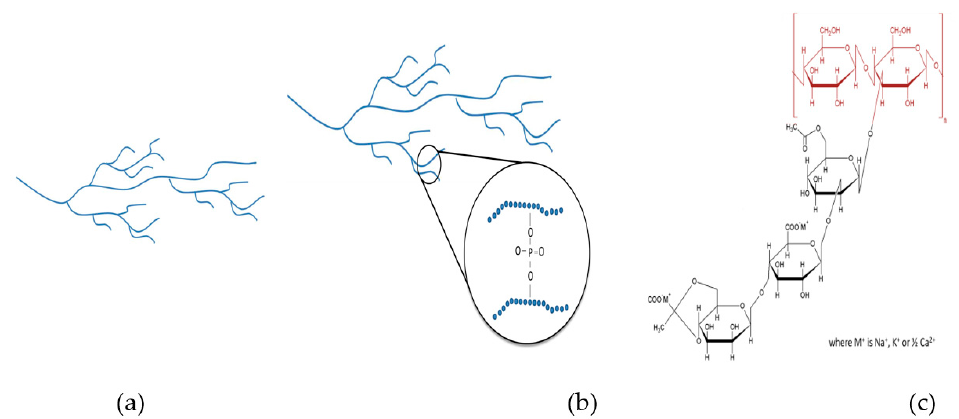
Figure 1. Schematic structures of ( a ) TS, ( b ) HDP/E-1442, and chemical structure of ( c ) XG. TS: tapioca starch; HDP: hydroxypropyl distarch phosphate; XG: xanthan gum.